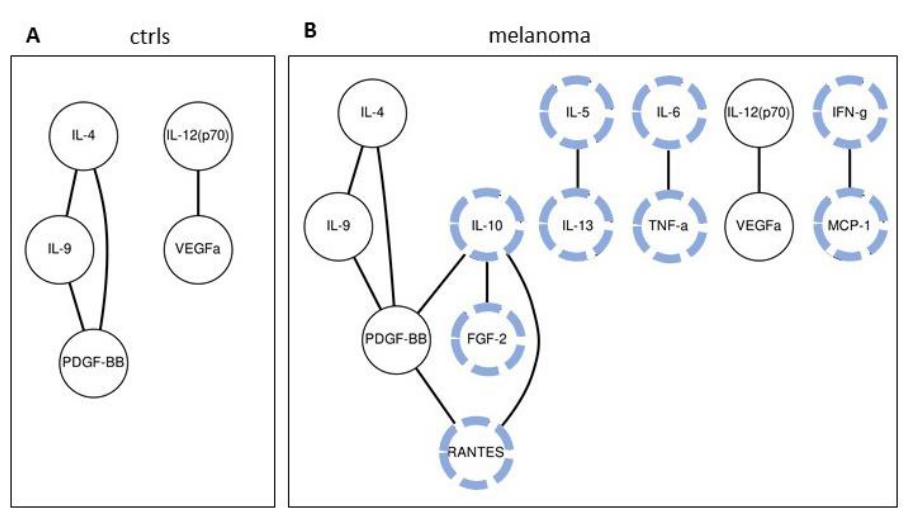
Figure 3. Correlation analysis of the serum expression values of all the control ( A ) and melanoma ( B ) samples. The connected circles show the paired molecules having p < 0.05 and Spearman’s R coefficient >0.70, in the control and melanoma samples, respectively. The correlations specifically present in the melanoma samples are highlighted with blue dashed lines.